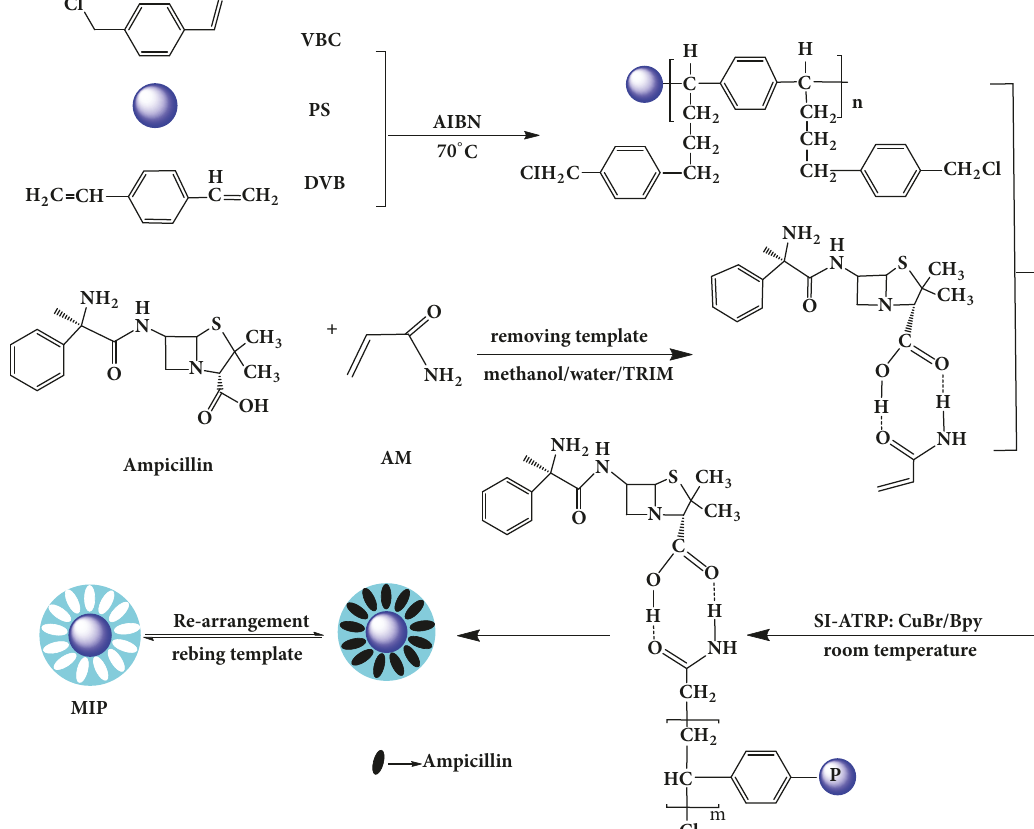
Figure 1: Synthetic route of surface-imprinted polymers (MIPs) microspheres.